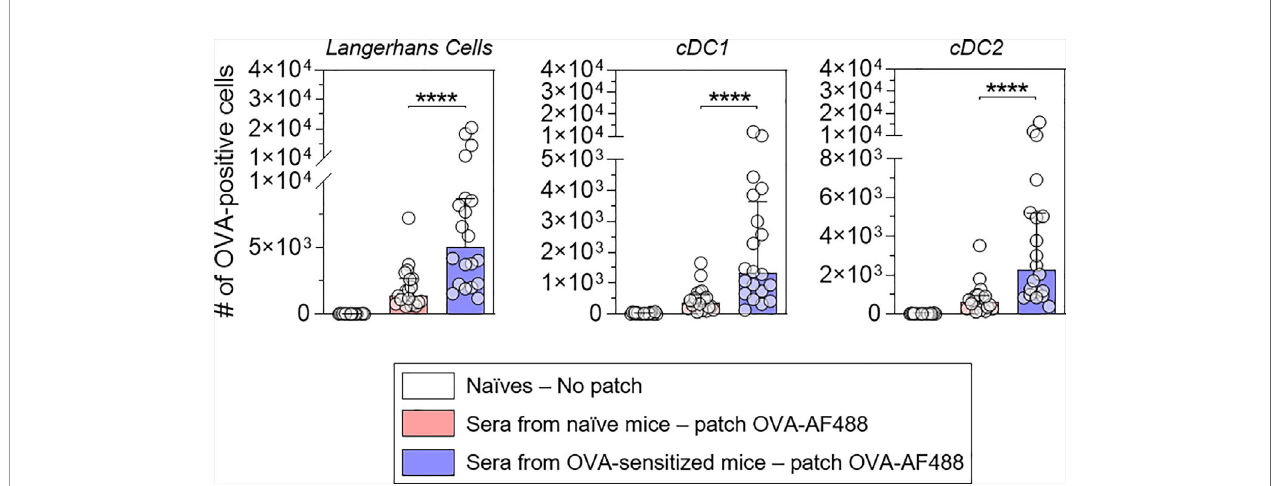
FIGURE 3 | Allergen-speci fi c humoral immunity promotes the increase of the number of OVA-positive migratory DCs in local lymph nodes. Mice were treated as described in Figure 2 . Forty-eight hours after patch application, brachial draining lymph nodes were collected, and cells were analyzed by Flow Cytometry. The number of OVA positive cells was quanti fi ed among migratory Langerhans cells, cDC1 and cDC2, as indicated (pool of two independent experiments, N = 10 per group for each of the two experiments). Data are median and interquartile ranges of individual values. P values were determined using the Mann-Whitney test (****P < 0.0001).